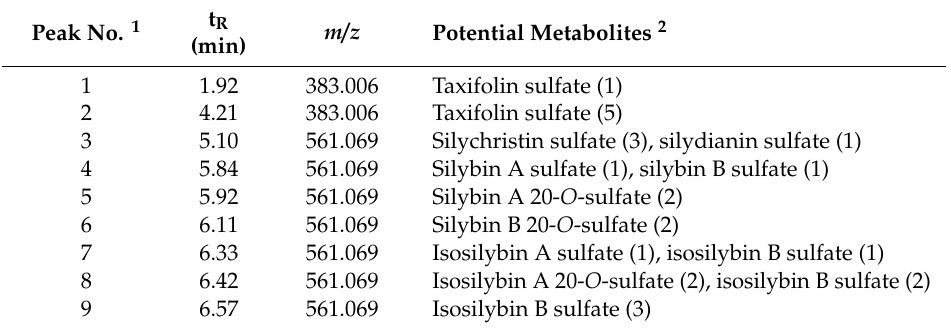
Table 3. Chromatographic peaks found after sulfation of silymarin mixture by human hepatocytes, human tissue cytosols, and human sulfotransferases. Peak No.